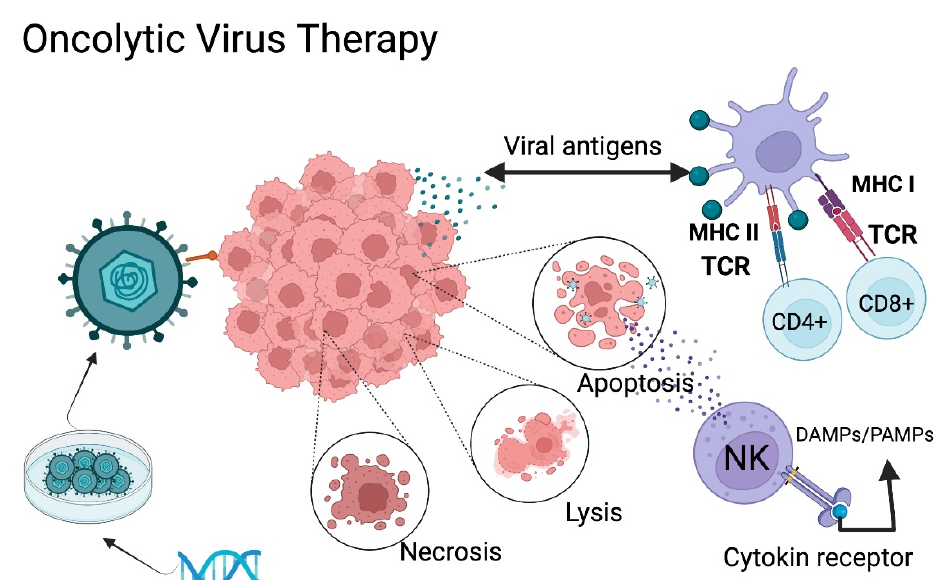
Figure 2. Oncolytic Virus Therapy Mechanism of Action. Oncolytic viruses (OVs) can be classified into two categories: natural viruses and genetically modified viruses. Modified viruses are loaded with specific receptors to recognize the GB through genetic engineering. The virus infects the tumor cells and generates either lysis, necrosis, or apoptosis, causing the release of tumor antigens, pathogen-associated molecular patterns (PAMPs), and damage-associated molecular patterns (DAMPs). The antigen-presenting cells present these antigens to T-lymphocytes, promoting activation of an adaptive immune response. TCR: T-cell receptor; NK: natural killer MHC I: Major histocompatibility complex class II. MHC II: Major histocompatibility complex class II. DAMPs: Damage-associated molecular patterns; PAMPs: Pathogen associated molecular patterns. Created with BioRender.com .